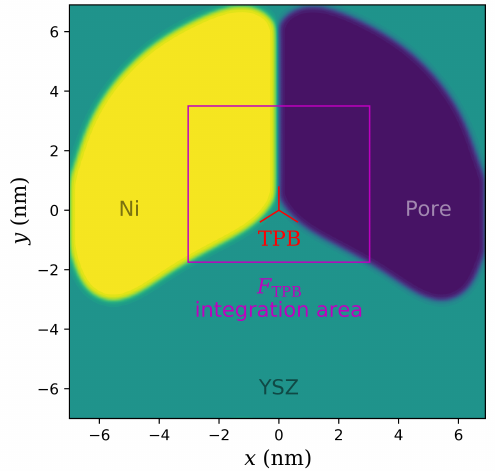
Figure 5. Diffuse phase distribution near a modeled triple phase